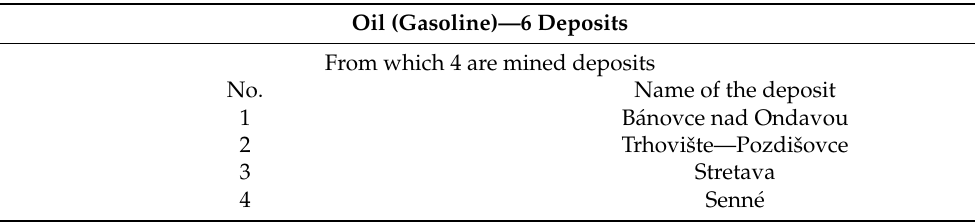
Table 3. Listing of the actual valid mined oil deposits, (source: elaborated by authors). Oil (Gasoline)—6 Deposits